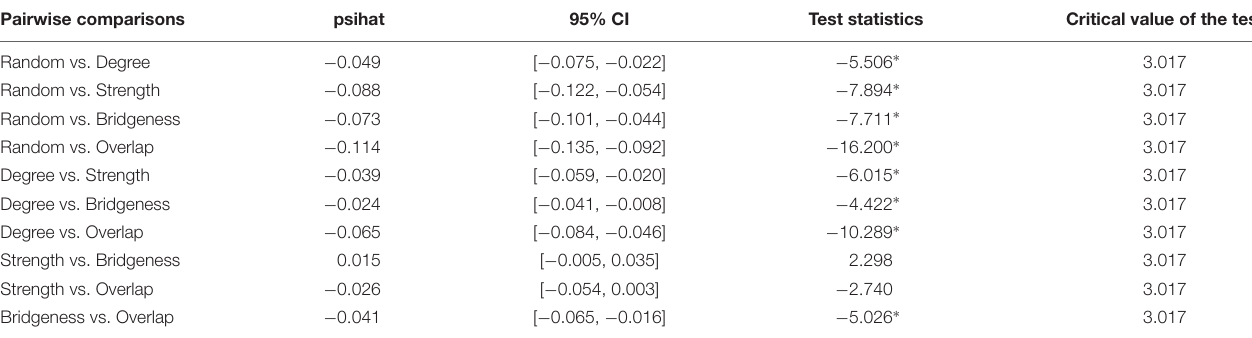
TABLE 6 | Post hoc comparisons between attack conditions of the impact of the extent of the attack on network connectivity. Pairwise comparisons psihat 95% CI Test statistics Critical value of the test Random vs. Degree − 0 . 049 Random vs.